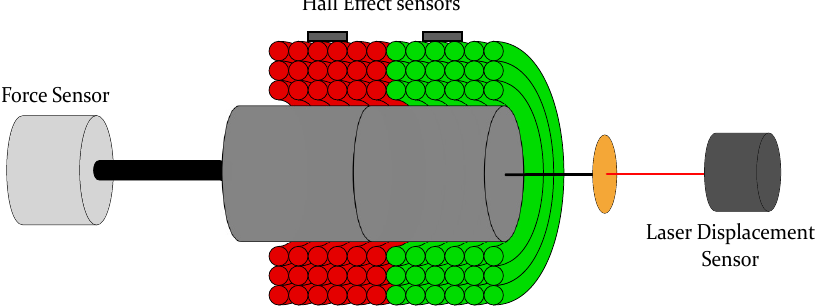
Figure 4. The testing apparatus of the coil showing the magnet mounted to the force sensor with the displacement being measured via the laser displacement sensor and the Hall effect sensors measuring the off-axis magnetic field.